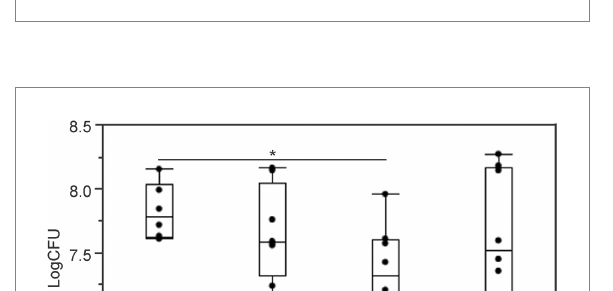
FIGURE 3 Survival curves of mice treated with vancomycin and mutacins via single-dose tail vein injection in a systemic MRSA infection. All treatments including the vehicle control were given to the animals in a sing-dose one-hour post-infection. Significance was observed among groups (log-rank test, value of p = 0.01). Pairwise comparisons using log-rank test showed statistical differences between K2A:R13A versus the control (value of p = 0.0115), vancomycin (value of p = 0.0065, and the Mu1140 (value of p = 0.0065). No difference was observed among the control, vancomycin, and Mu1140 groups ( n = 12 for the vehicle control and vancomycin, n = 6 for the Mu1140 and K2A:R13A; all groups contained equal numbers of male and female mice).